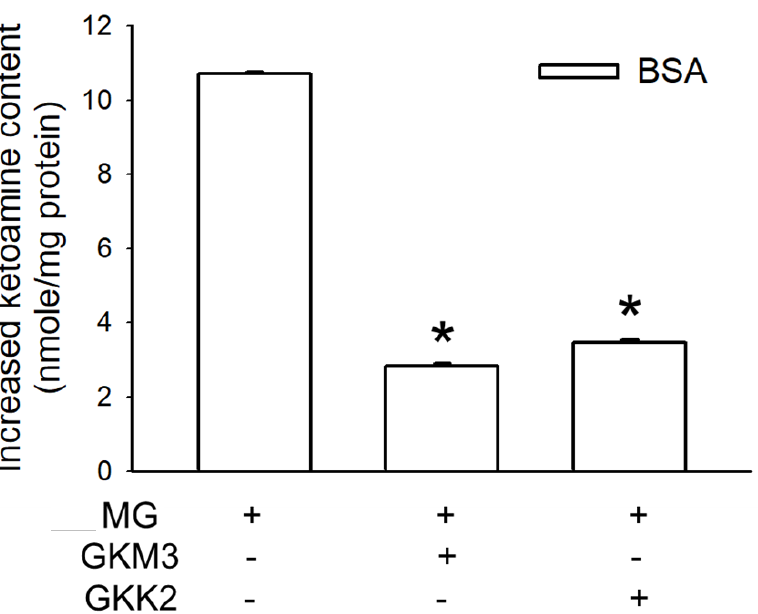
Figure 1. Effect of GKM3 and GKK2 on the formation of Amadori products in the early stage of protein glycation. Data unit was expressed as the increased nmole of ketoamines per mg of protein of samples. Data shown are means of results calculated by values of glycated BSA groups minus values of native BSA groups obtained from three independent experiments. * means statistical differences vs. data of the group of BSA treated with MG only. BSA: bovine serum albumin; MG: di- carbonyl-methylglyoxal.